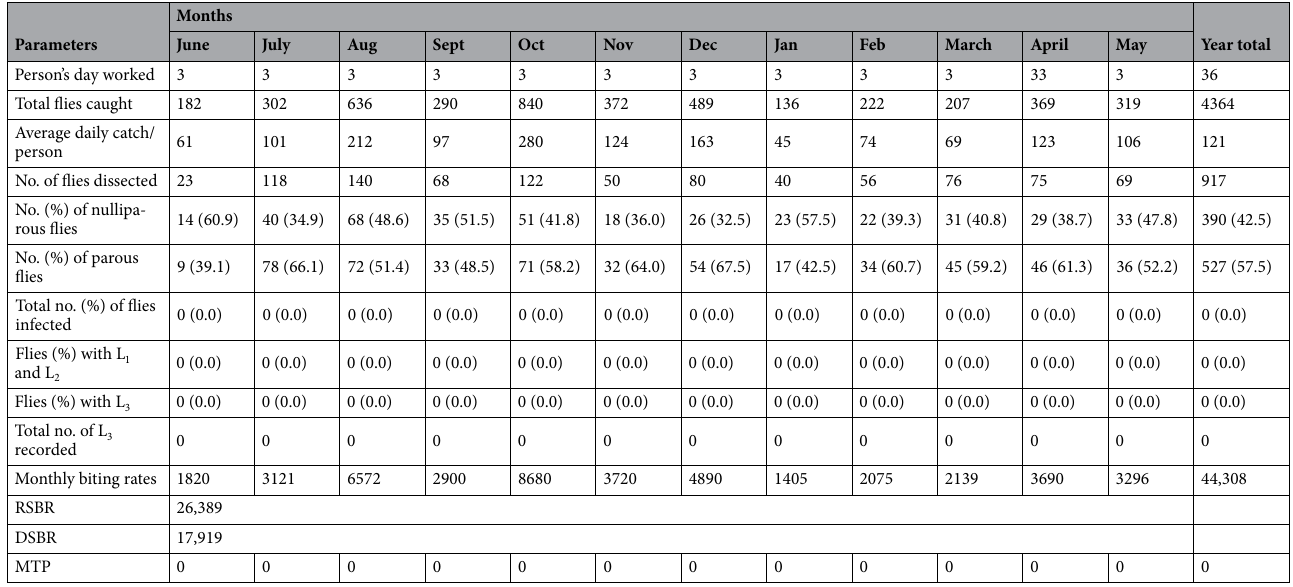
Table 3. Population density and transmission indices of S. damnosum at Ekong Anaku River. [RSBR = Rainy season biting rate (May–October), DSBR = Dry season biting rate (November–April)].